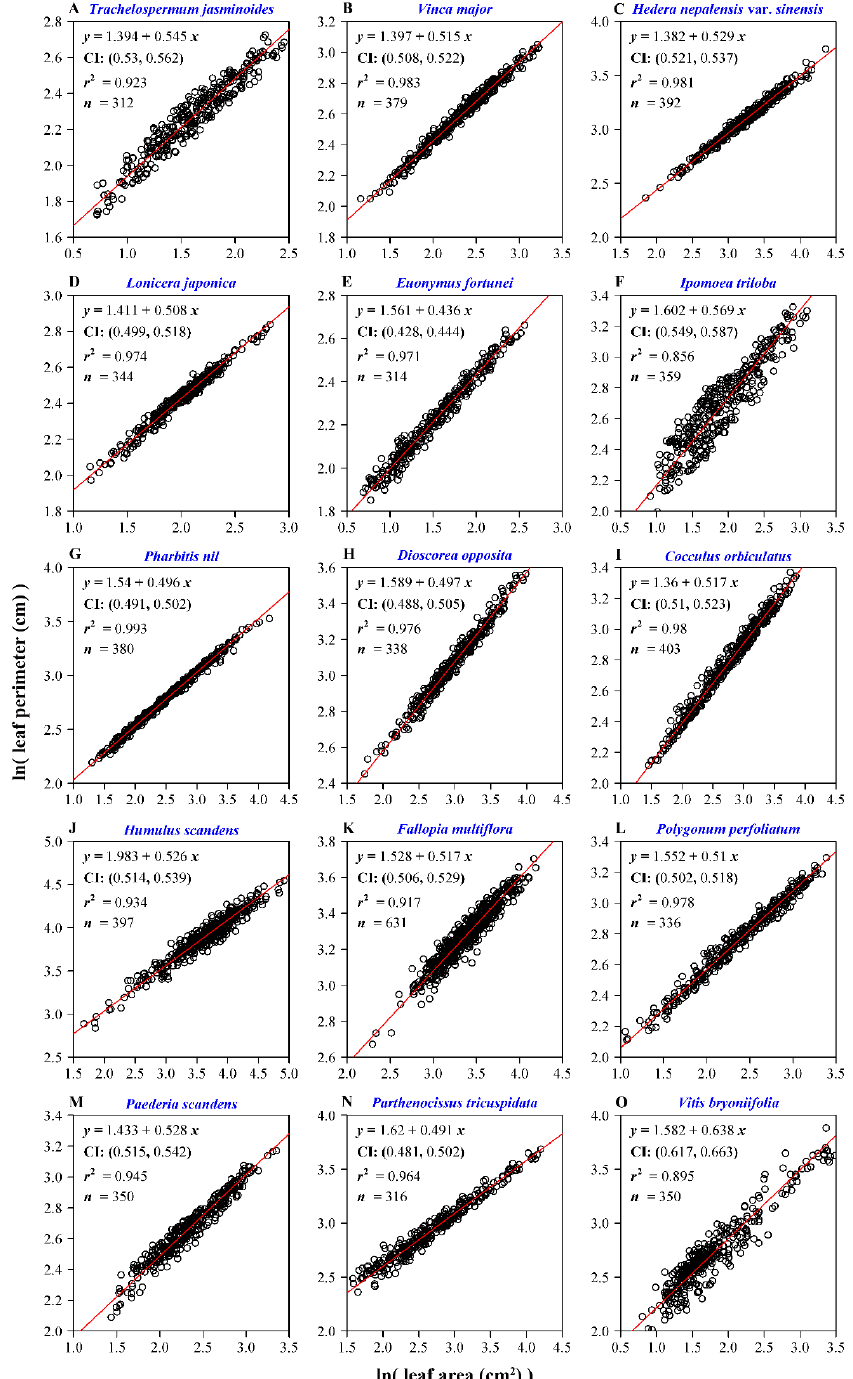
Figure 5. Scaling relationships between leaf perimeter and area for the 15 species of vines. Panels ( A – O ) represent different vine species. In each panel, y represents the natural logarithm of leaf perimeter in cm; x represents the natural logarithm of leaf area in cm 2 ; CI represents the 95% confidence intervals of the slope based on 3000 bootstrapping; r 2 is the coefficient of determination, which measures the goodness of fit for a reduced major axis regression; and n is the sample size (i.e., the number of data points).